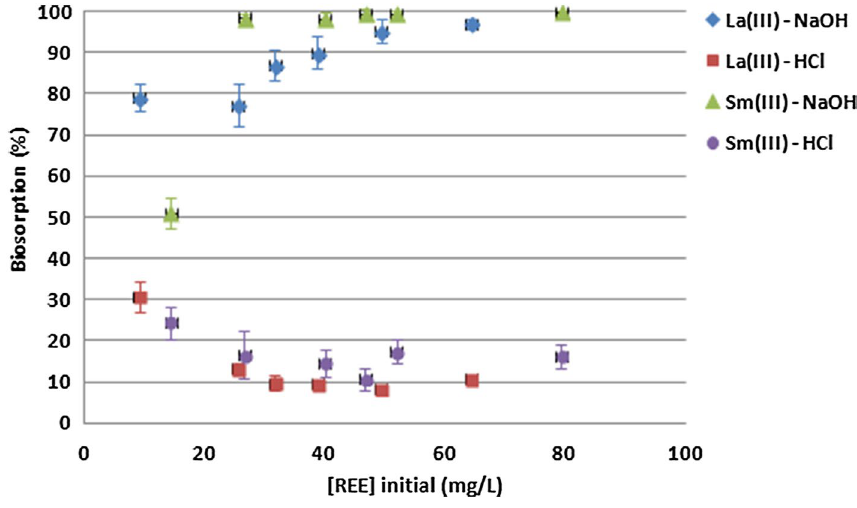
Fig. 1 Effect of initial concen- tration on the biosorption of La 3+ and Sm 3+ by pre-treated Bacillus subtilis cells in single